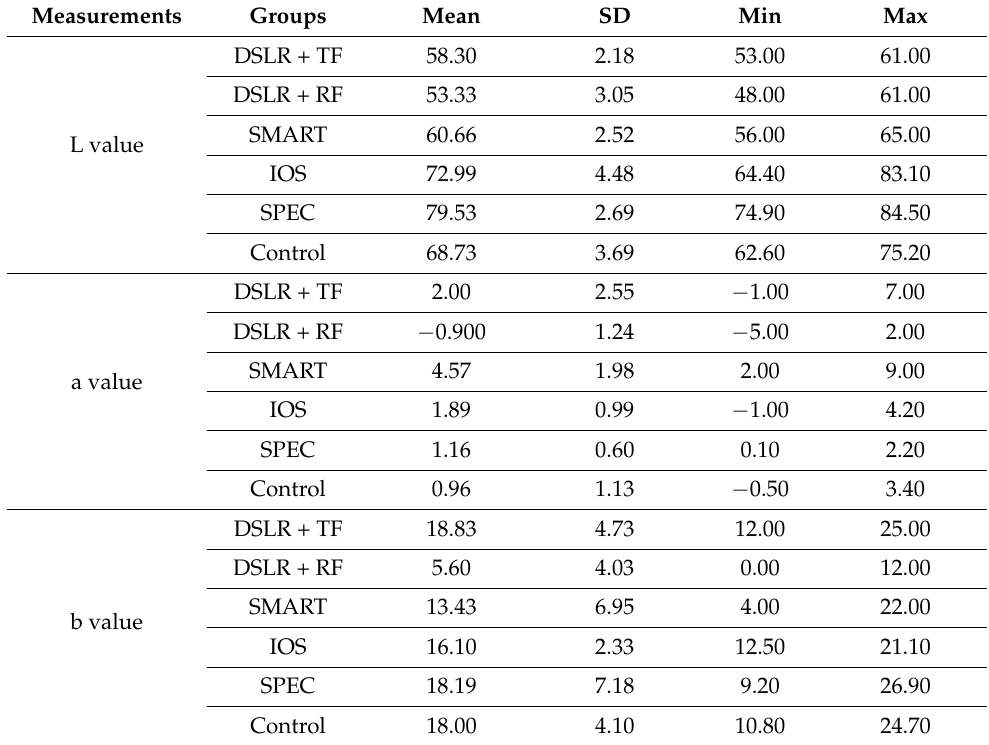
Table 6. The distribution of CIE Lab values from all groups. Measurements